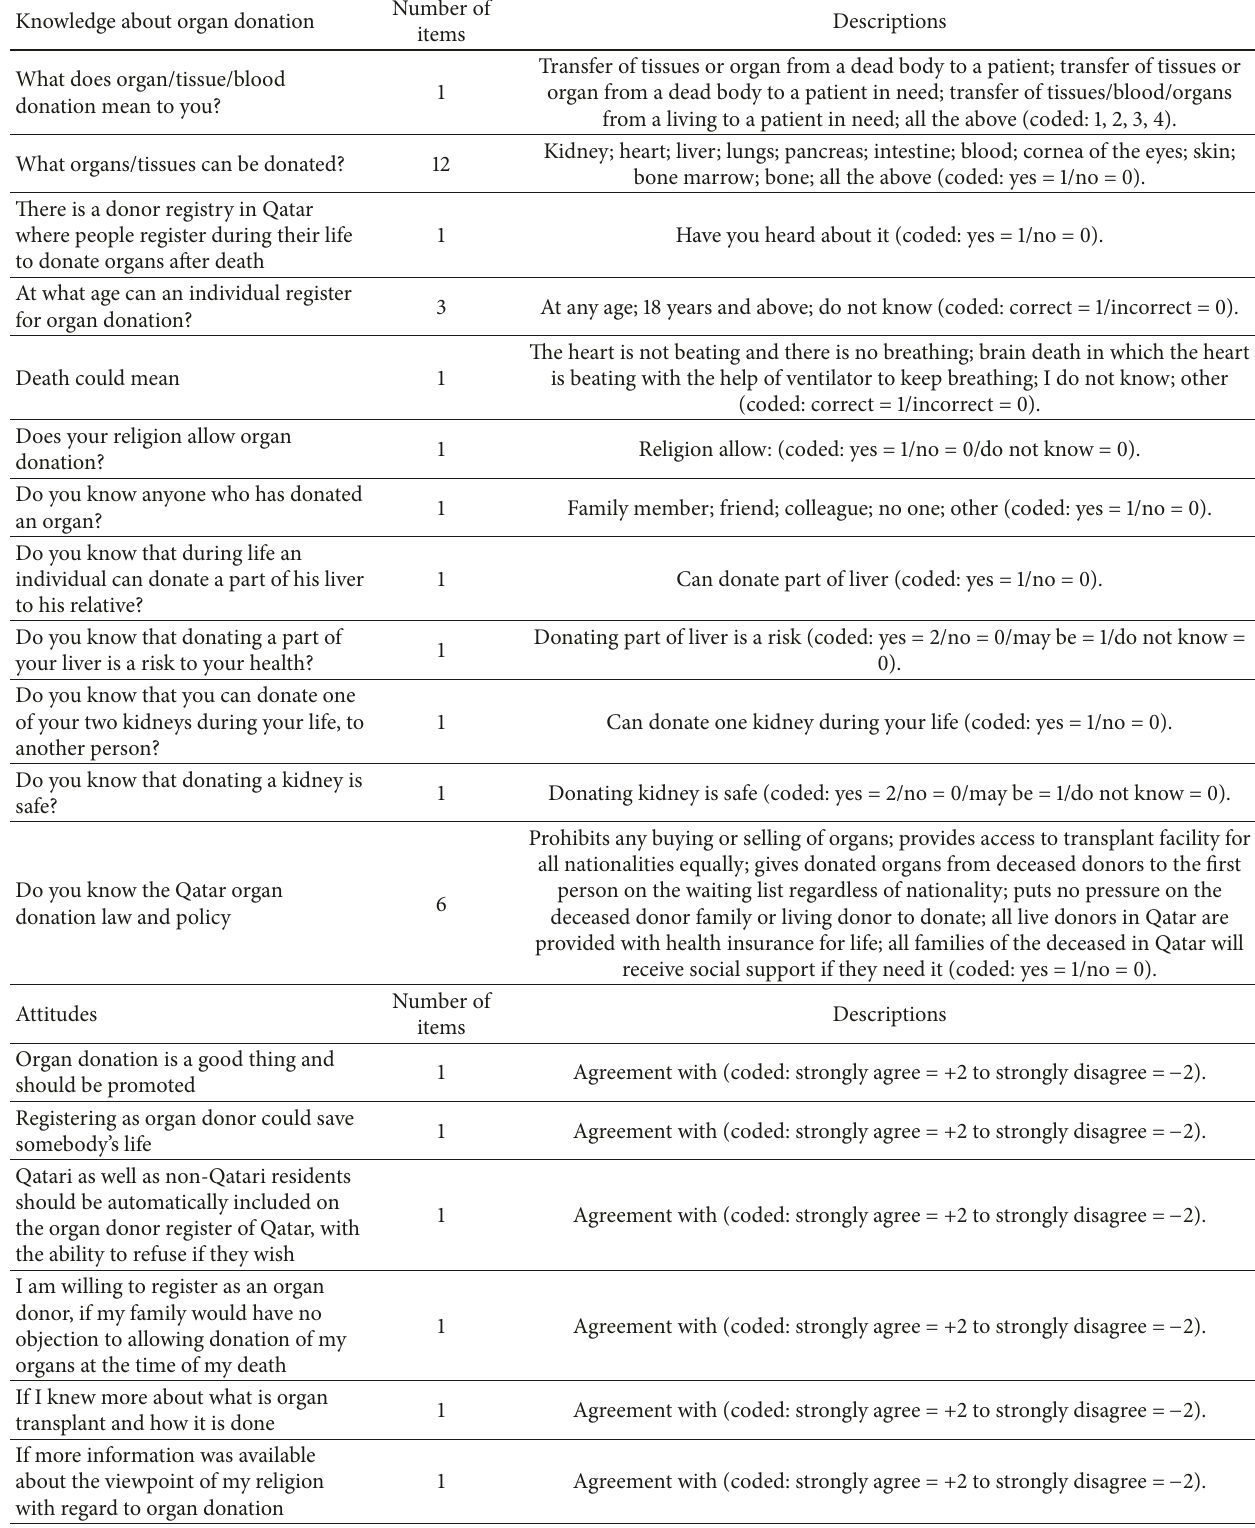
Table 2: Description of questionnaire